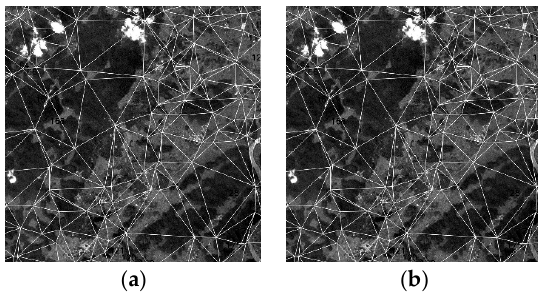
Figure 6. Delaunay triangulation. ( a ) Reference band (subset). ( b ) Band to be registered (subset).